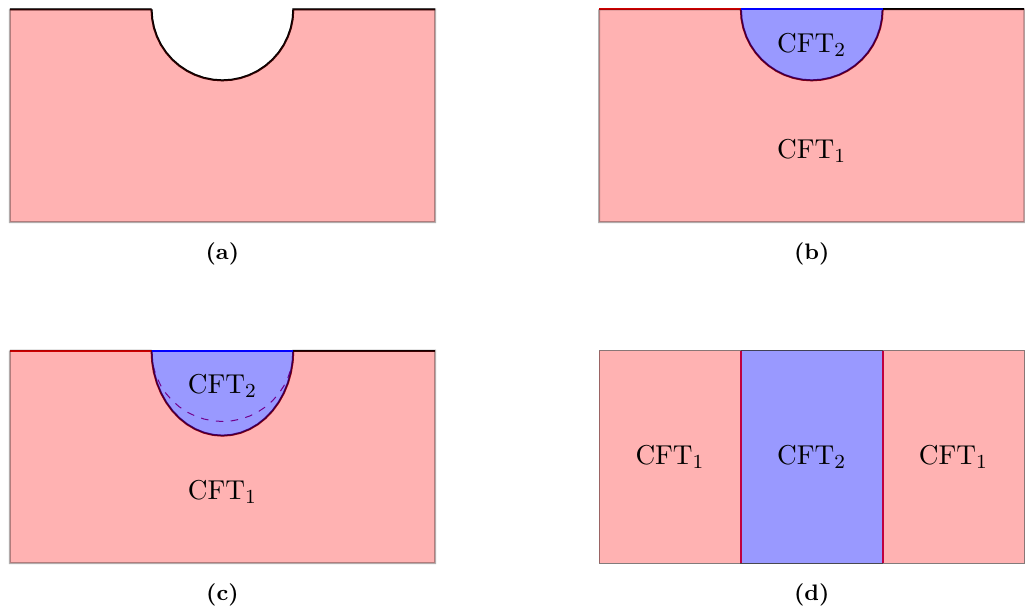
Figure 2. (a) Path integral for the state of two BCFTs approximating the vacuum state of CFT 1 (b) Path integral for an interface theory with an auxiliary CFT coupling the left and right